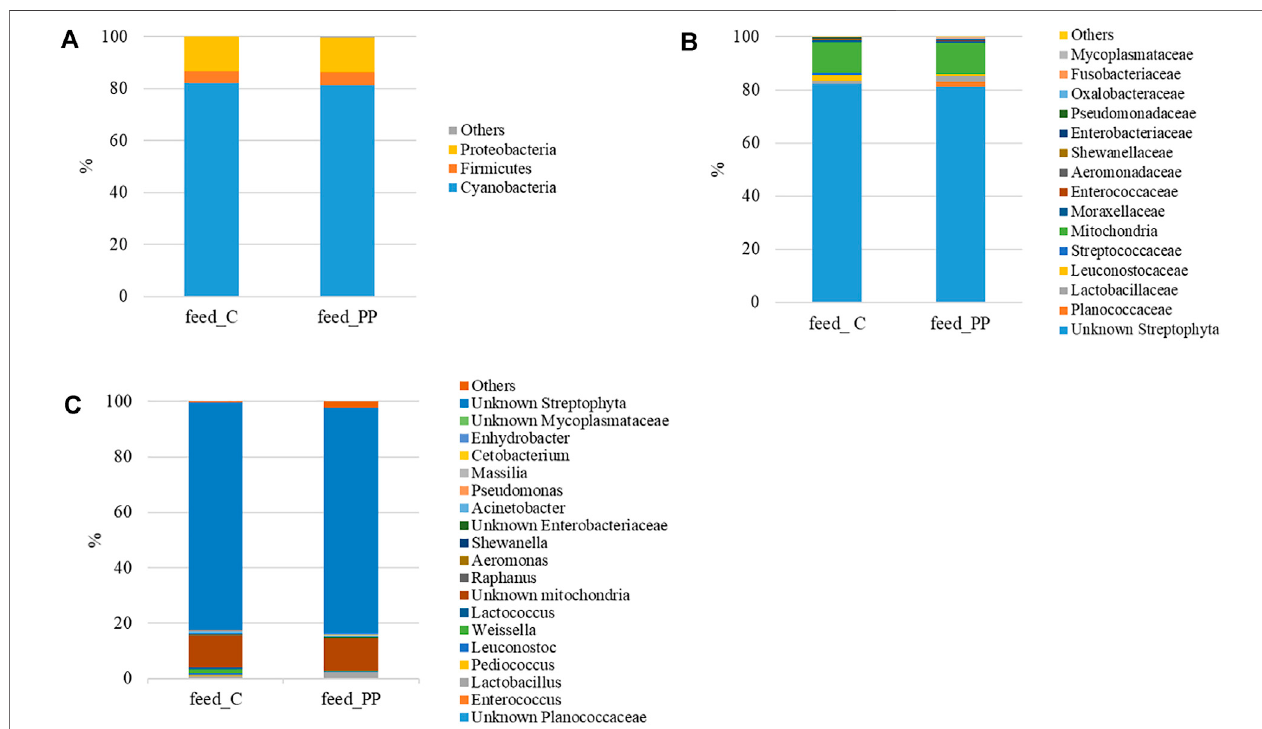
FIGURE 1 | Mean relative abundance (%) of the most prevalent bacterial taxa in experimental feeds at ( n = 3) phylum (A) , family (B) , and genus (C) levels.